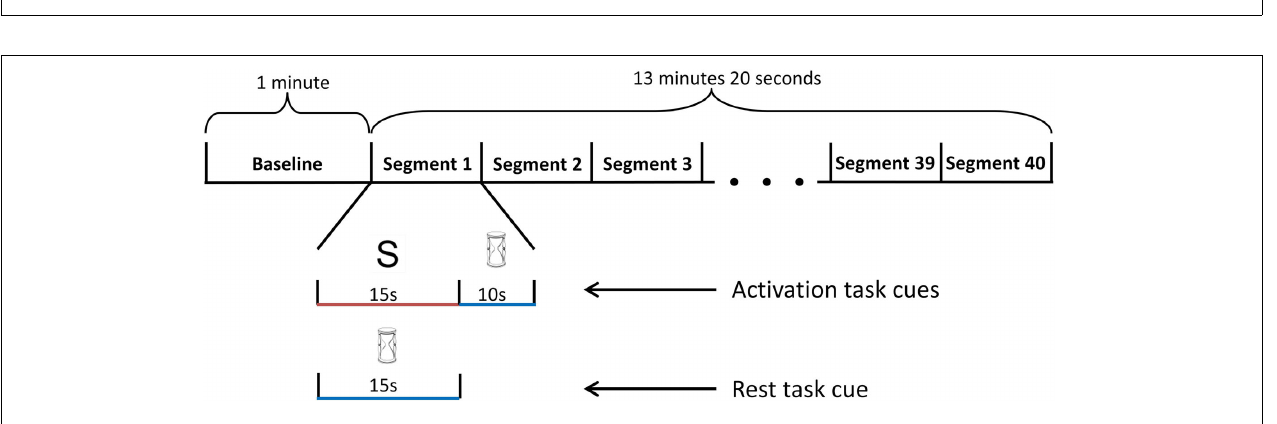
FIGURE 4 | Schematic diagram of the training block. The training block began with a 1-minute baseline period, followed by 40 randomized task segments. During each task segment, the screen randomly displayed either an hourglass or a letter. If a letter was presented, the participant performed